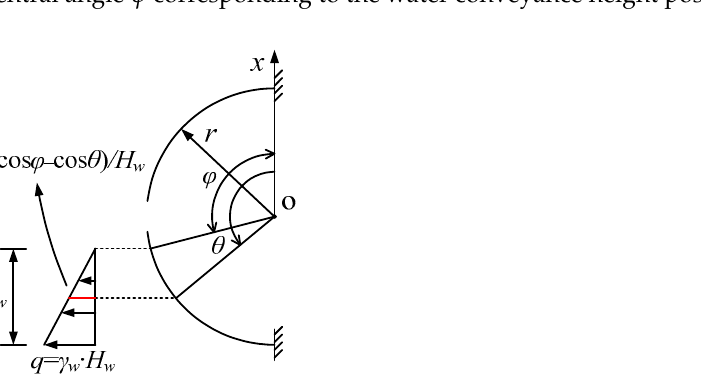
Figure 6. Load diagram of the water level at the lower part of the tunnel.